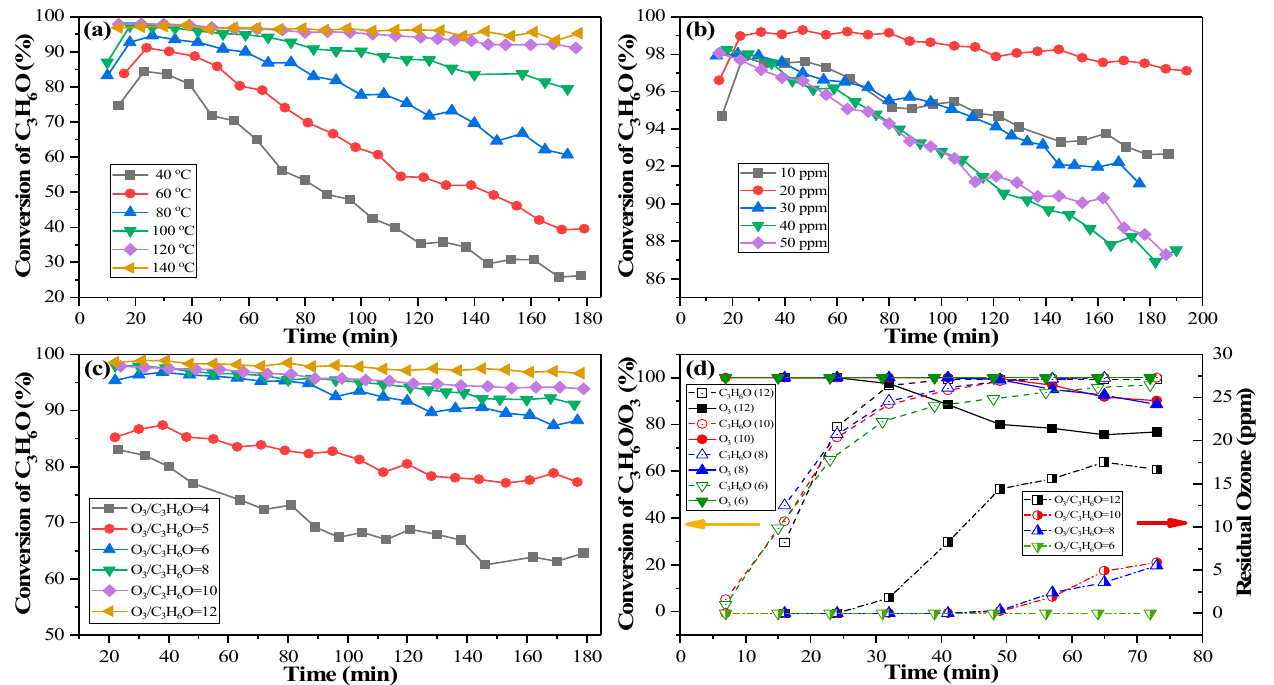
Figure 5. The C 3 H 6 O conversion efficiencies over Cr1.5% catalysts. ( a ) different temperatures; ( b ) different C 3 H 6 O initial concentrations; ( c ) different O 3 /C 3 H 6 O molar ratios. ( d ) C 3 H 6 O and O 3 conversion efficiencies and residual ozone under different O 3 /C 3 H 6 O molar